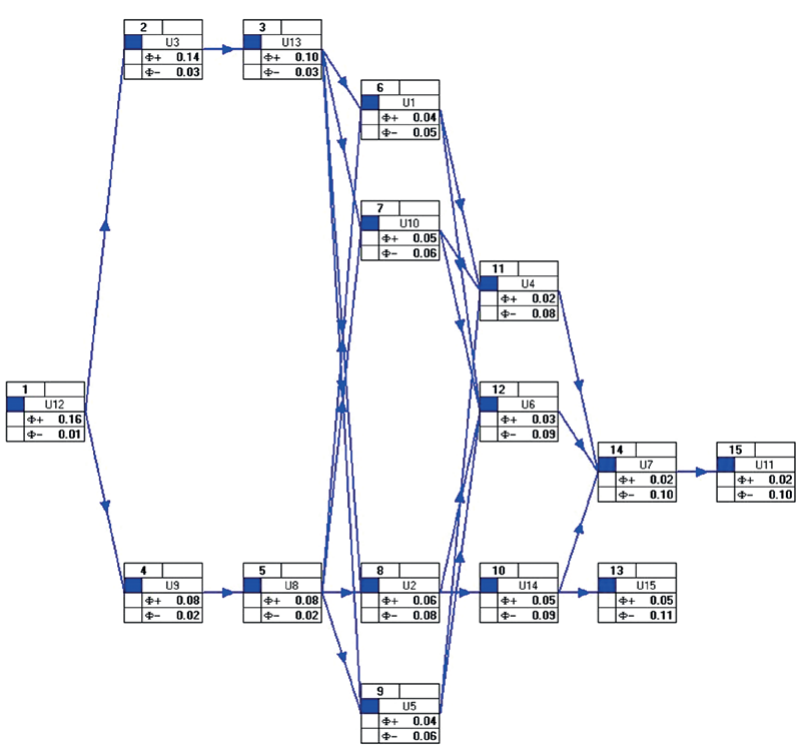
Fig. 3. PROMETHEE I partial ranking